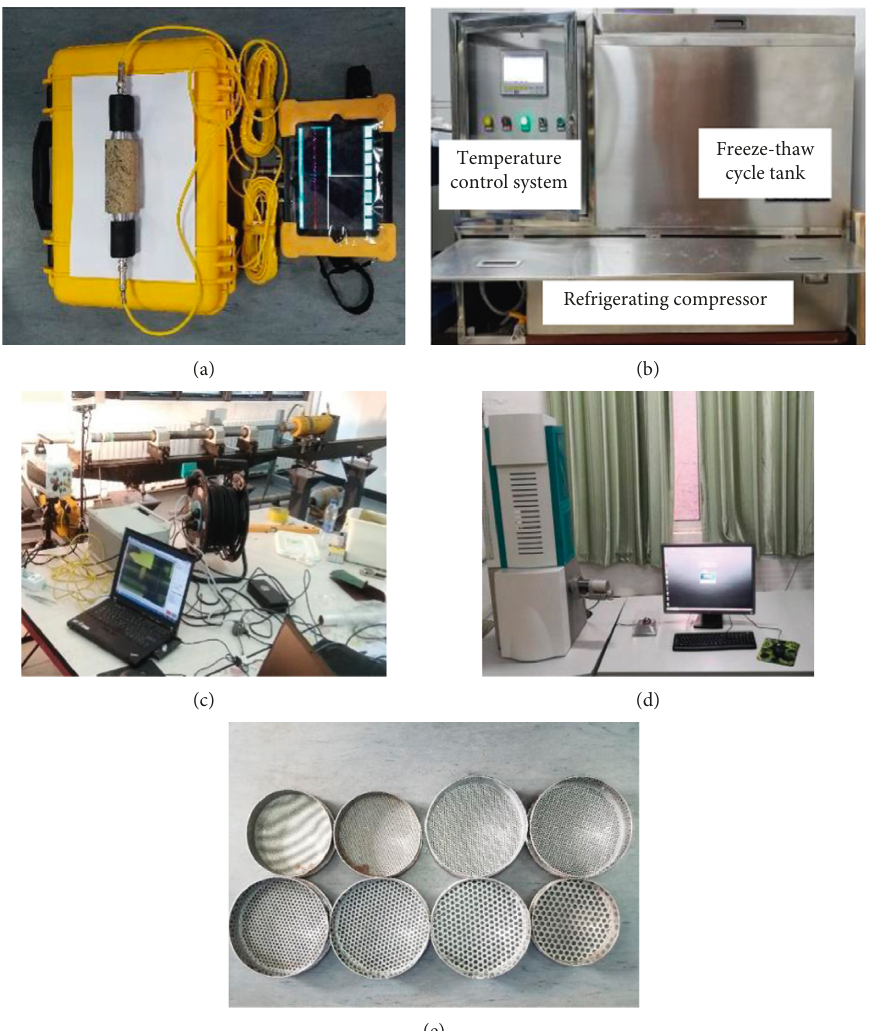
Figure 4: Testing systems in this work. (a) P -wave velocity monitoring system. (b) Freeze-thaw cycle equipment. (c) Impact loading test equipment. (d) SEM device. (e) Classifying screen.